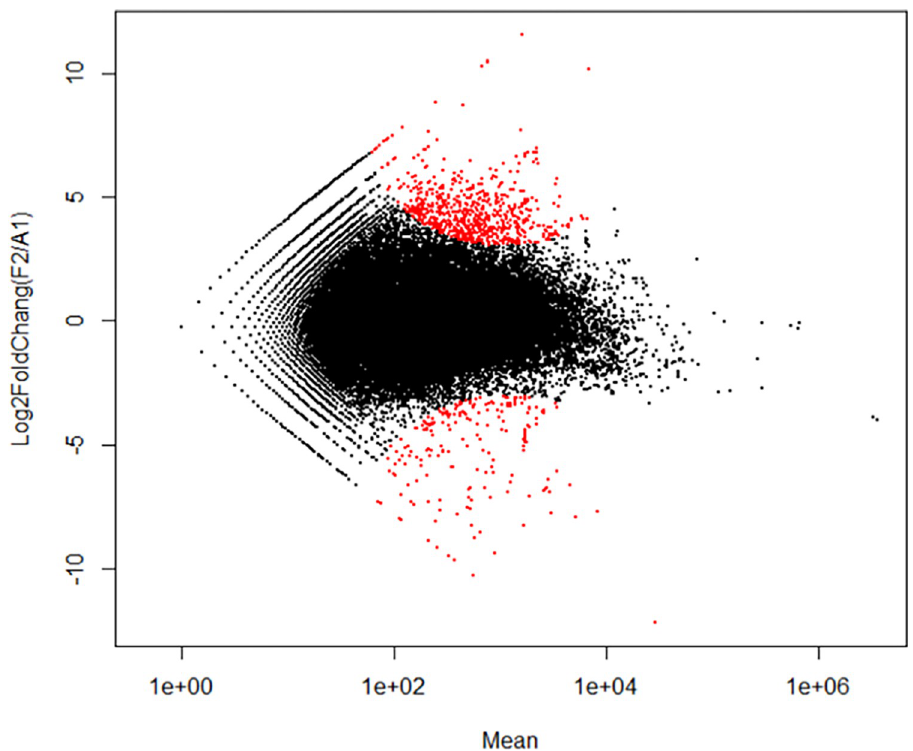
Fig 7. Fold change and mean plot between unstressed and anhydrobiotic H . indica IJ using DESeq program (transcripts with p-value < 0.01 in red).